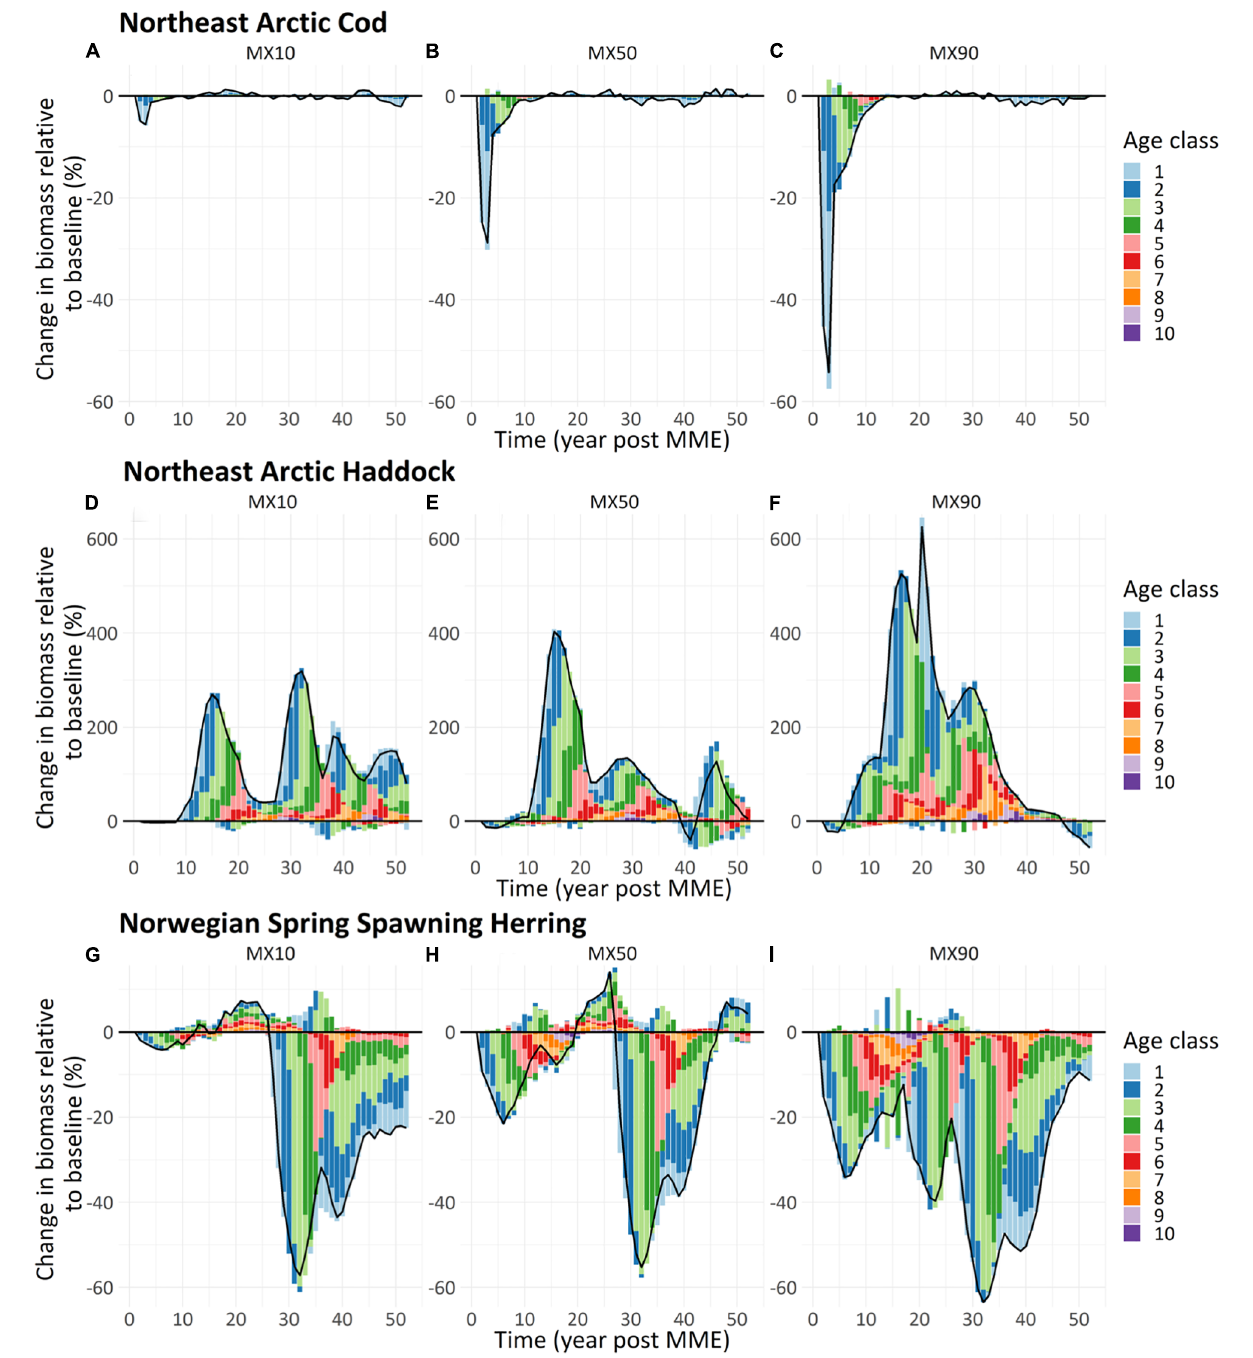
FIGURE 3 | Change in age structure biomass (% relative to baseline run) of the modeled age classes (1–10) for (A–C) Northeast Arctic cod ( Gadus morhua ), (D–F) Northeast Arctic haddock ( Melanogrammus aeglefinus ), and (G–I) Norwegian spring spawning herring ( Clupea harengus ) following three reduced mortality events (Panels: A: –10%, B: –50%, C: –90%) modeled using the NoBa Atlantis ecosystem model. The black line shows the change in total biomass of the population. Year 0 is the year of the mortality